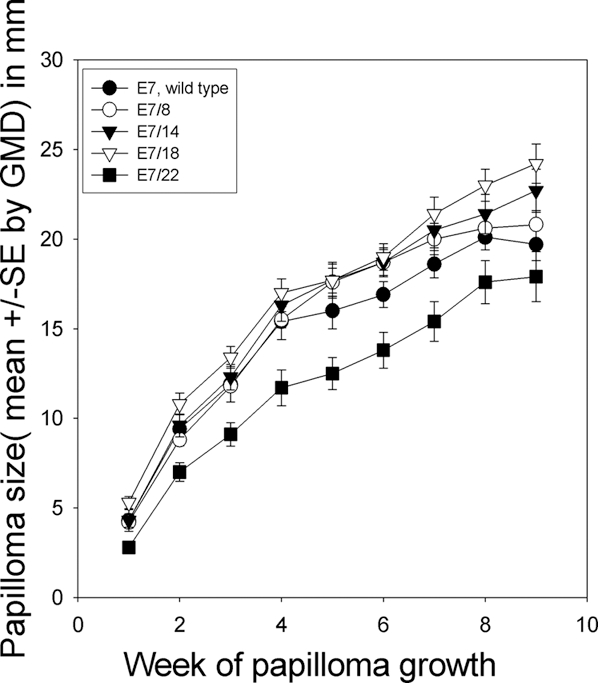
Sizes of papillomas differed among the different genotypes.Growth curves of papillomas following infection with wild type and codon-optimized genomes. E7/8 and E7/14 papillomas grew at about wild type rate; E7/18 papillomas grew statistically faster than E7/22 papillomas (P<0. 001, unpaired student's t test); E7/18 papillomas grew statistically faster at later time points than wild type papillomas (P<0.03 unpaired student's t test).